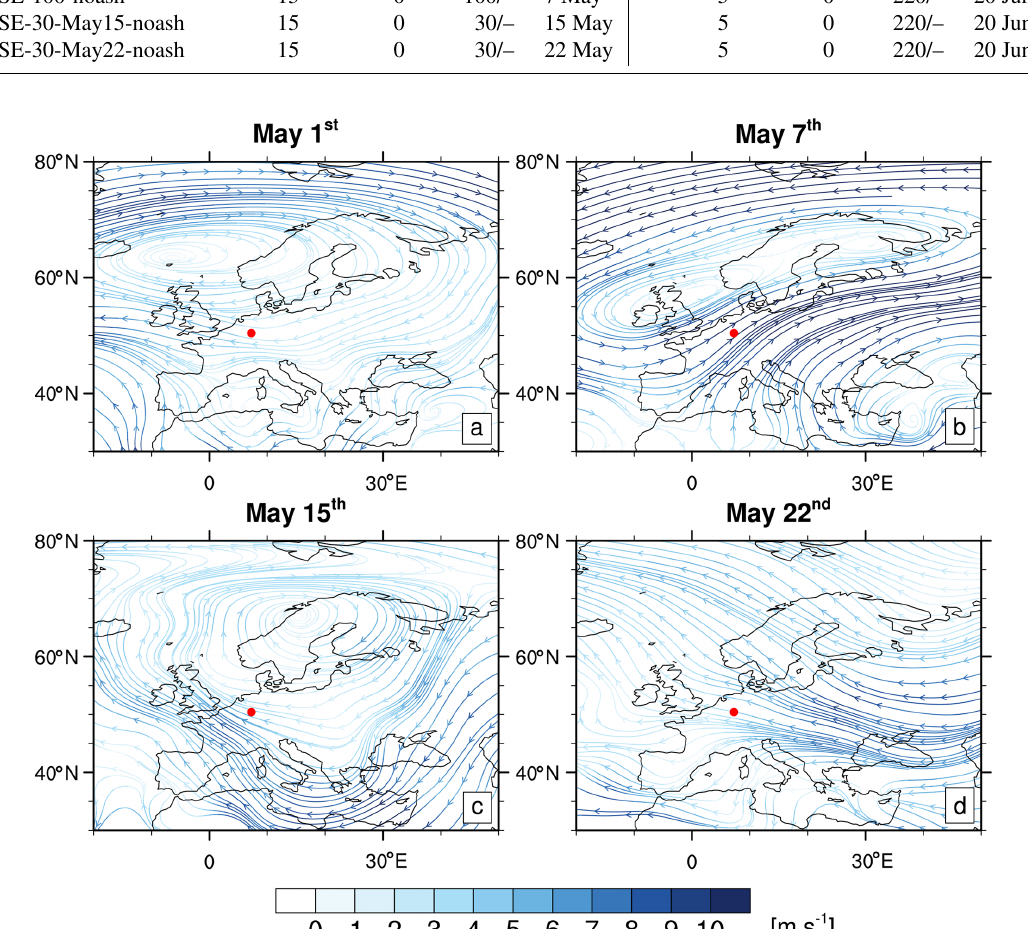
Figure 2. Streamlines over Europe of the undisturbed zonal wind [ms − 1 ] at 48hPa. The panels show 1-week separated snapshots of the flow pattern in May with (a) westward flow over central Europe on 1 May, (b) eastward flow on 7 May and northwestward flow on (c) 15 May and (d) 22 May. The red dots mark the eruptive